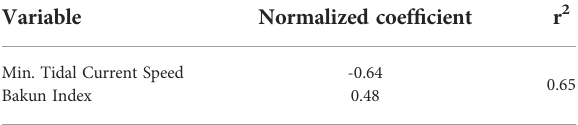
TABLE 1 Multiple linear regression analysis results for the dependence of the potential renewal strength on the minimum smoothed tidal current speed and the Bakun